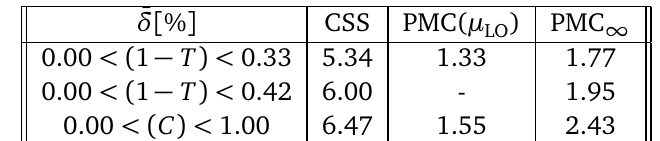
Table 1: Average error, ¯ δ , for NNLO Thrust and C-parameter distributions under CSS, PMC( µ ) and PMC ∞ scale settings calculated in different LO